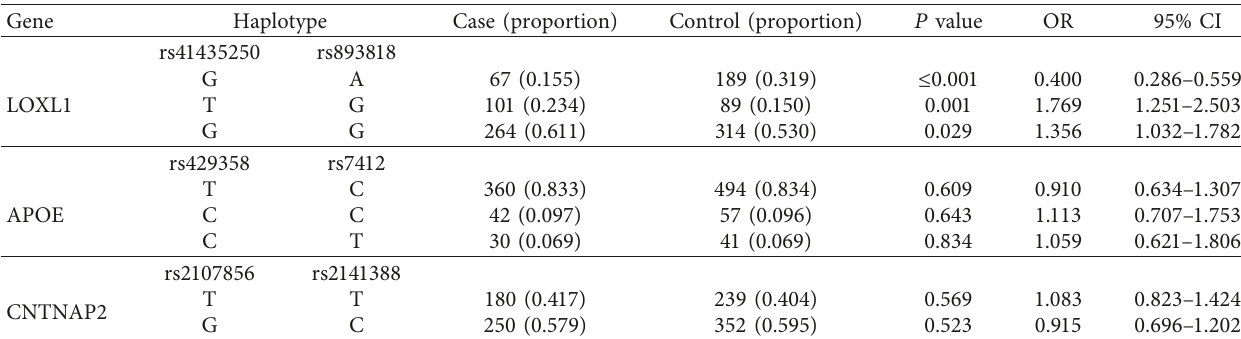
Table 7: Haplotype (adjusted) association analysis between these SNPs.